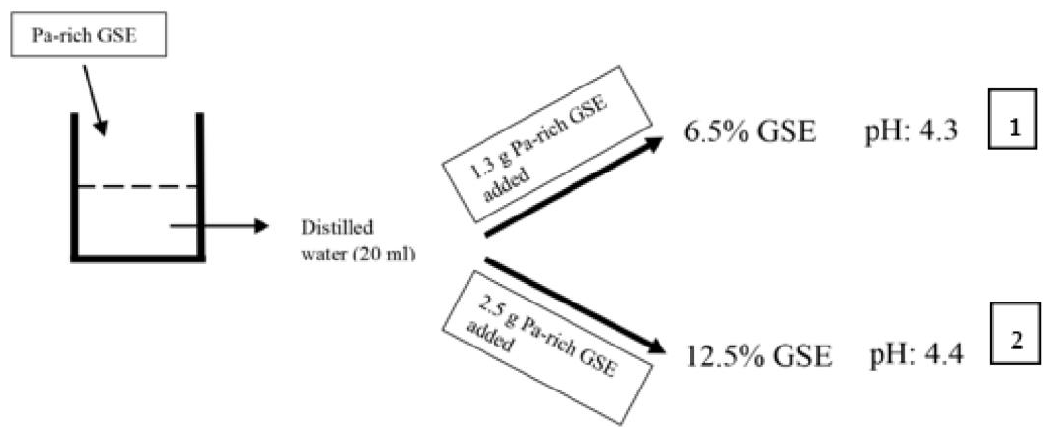
Figure 1. Experimental setup of two different concentrations of proanthocyanidin extract. Pa-rich GSE: proanthocyanidin-rich grape seed extract.